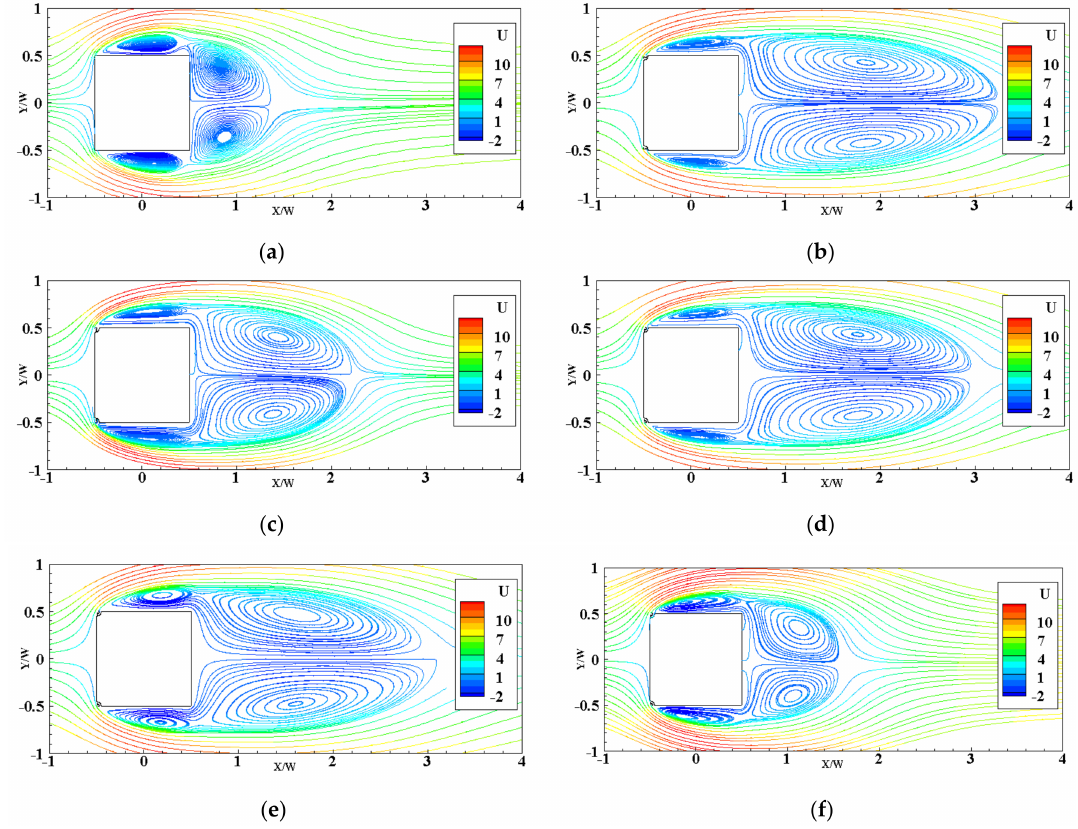
Figure 13. Time-averaged streamlines around the cylinder: ( a ) plain cylinder; ( b ) S2 ; ( c ) S4 ; ( d ) R1 ; ( e ) R6 ; ( f ) R8